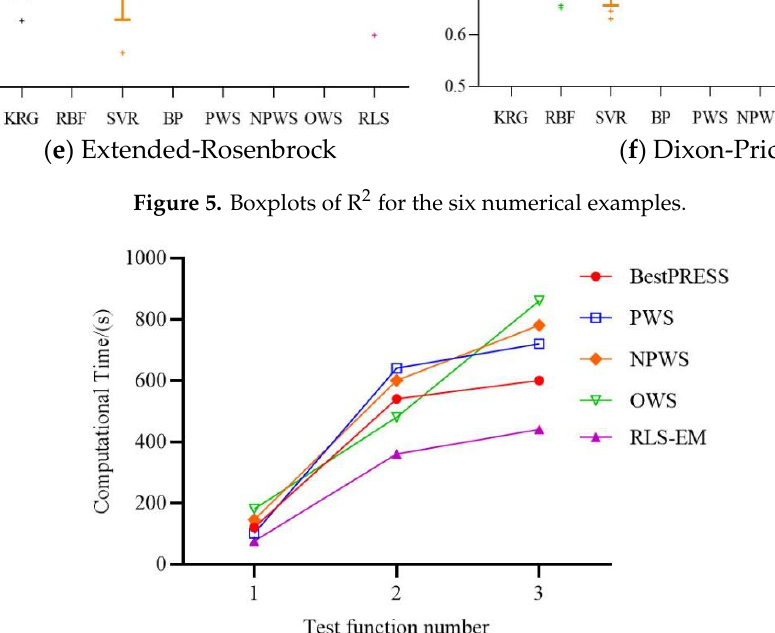
Figure 5. Boxplots of R 2 for the six numerical examples.